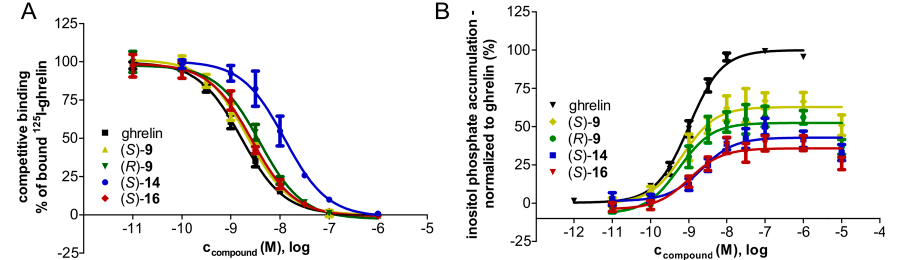
Figure 1. Binding affinity ( A ) and agonistic properties ( B ) of the non-peptidic candidate compounds ( S )- 9 , ( R )- 9 , ( S )- 14 , and ( S )- 16 . Compounds were tested at membranes of HEK293 cells stably transfected with the hGhrR for competitive binding properties against [ 125 I]ghrelin ( A ); Data are means ± SEM ( n ≥ 4). Agonistic properties of the compounds were analyzed by inositol phosphate accumulation in COS7 cells stably transfected with the hGhrR ( B ). Data were normalized to ghrelin (100% = maximal efficacy, 0% = constitutive receptor activity) and given in percent as means ± SEM of ≥ 3 independent experiments performed in duplicates.